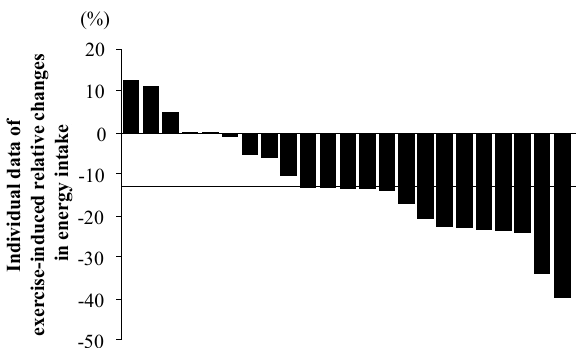
Figure 3. Individual data of exercise-induced relative change in energy intake. The line indicates the average value of relative change in exercise-induced energy intake ( − 12.9% ± 2.8%).